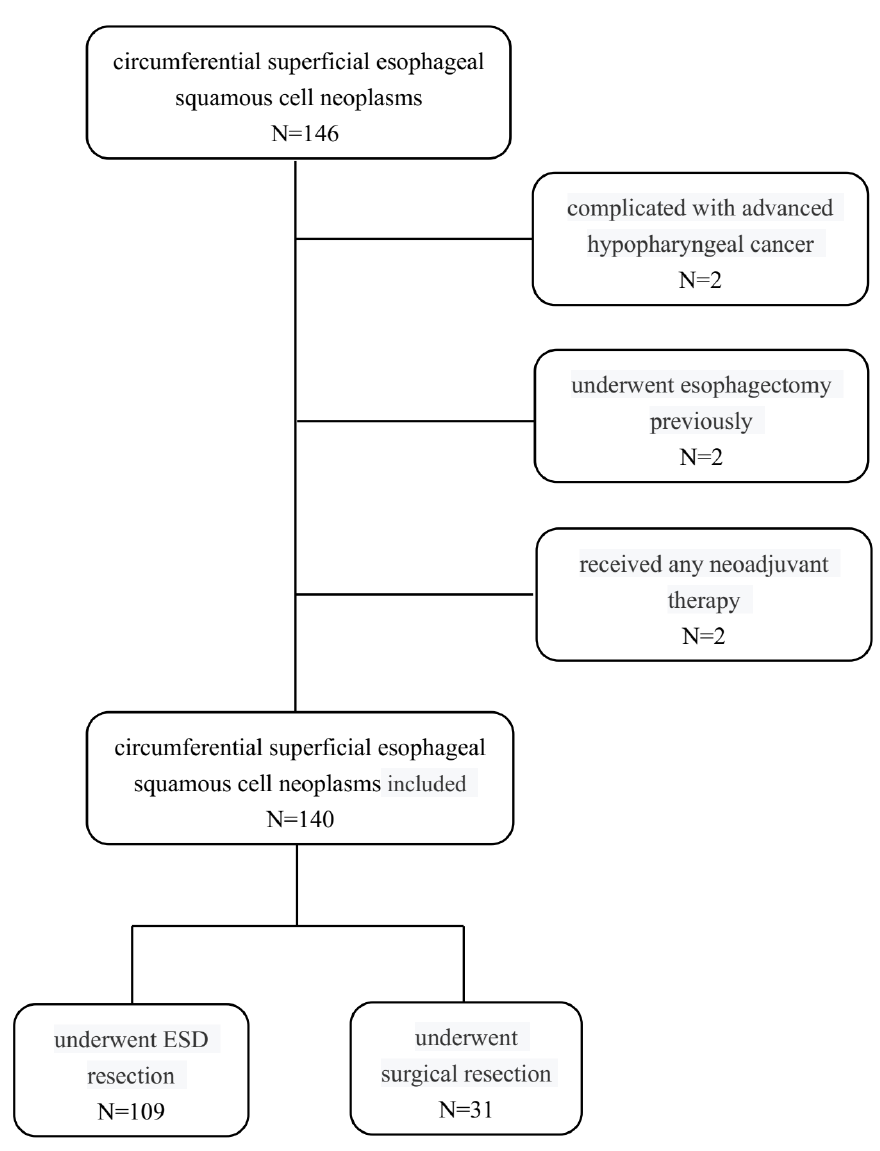
Figure 1. Flow chart of the current